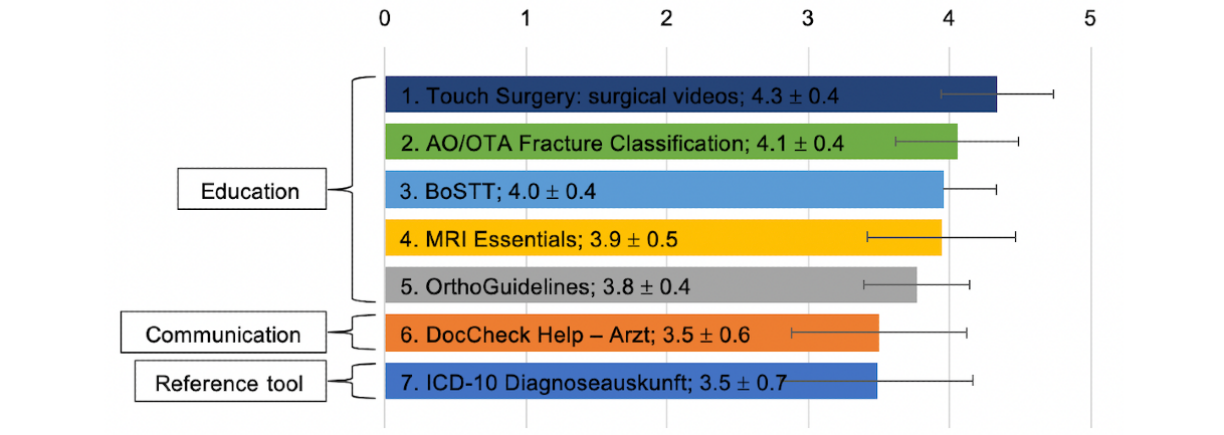
Figure 3. Mean overall rating for trusted apps using the “MARS-G”. Every single app was ranked by two raters. AO/OTA: Arbeitsgemeinschaft für Osteosynthesefragen/Orthopedic Trauma Association; BoSTT: bone and soft tissue tumors-case studies; ICD-10: International classification of diseases, tenth revision; MRI: magnetic resonance imaging; MARS-G: German Mobile App Rating